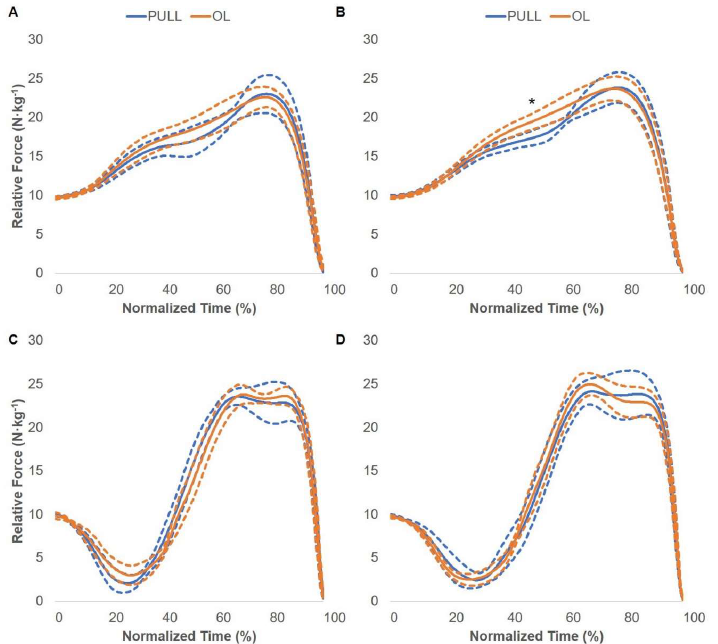
Figure 7. PULL and OL group squat jump and countermovement jump force–time curve adaptations. Pre- ( A ) and post-intervention ( B ) squat jump force–time curve adaptations. Pre- ( C ) and post-intervention ( D ) countermovement jump force–time curve adaptations. Solid and dashed lines display the group average and 95% confidence intervals, respectively. * = statistically significant difference in relative force.